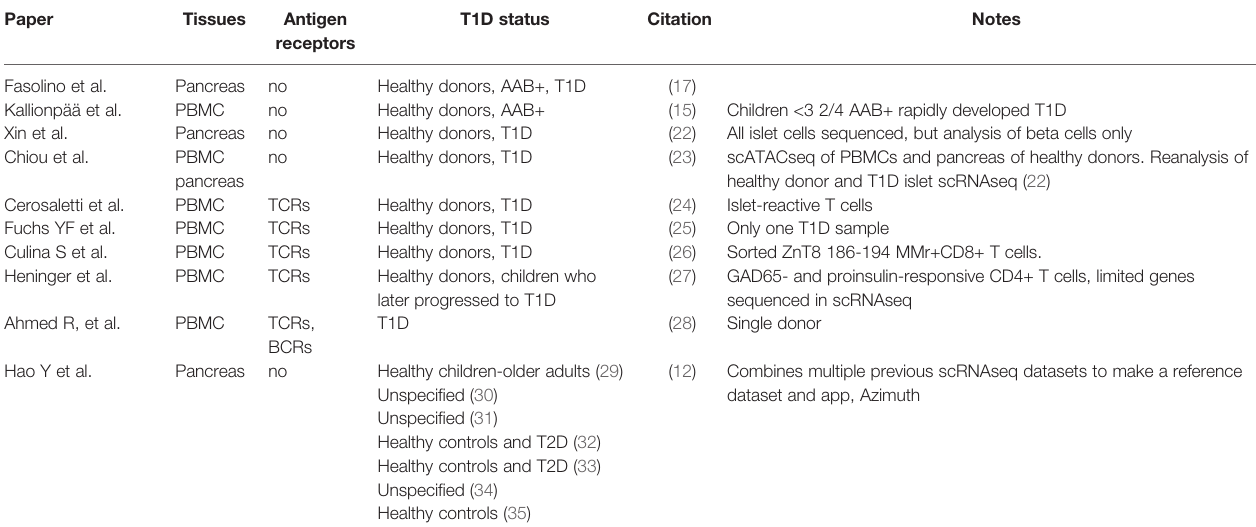
TABLE 1 | human scRNAseq gene expression studies relevant to type 1